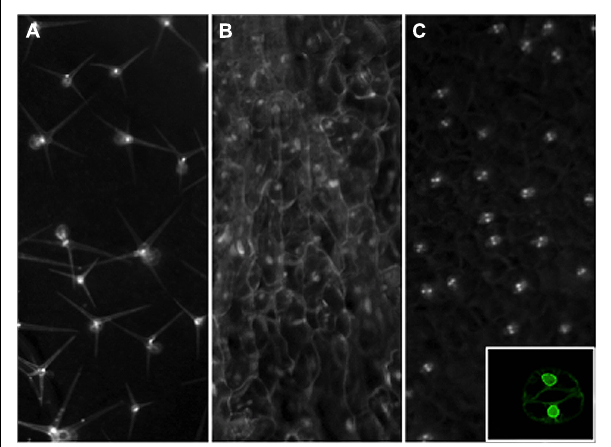
FIGURE 2 | Nuclear envelope tagging of specific leaf cell types in Arabidopsis . Transgenic plants were created with Inserts that express an NTF marker gene driven by the GL2 (A) , CaMV35S (B) , or AtMYB60 (C) promoters for trichome, constitutive, or guard cell-specific expression.The NTF marker is a nuclear envelope-anchored GFP fused to a biotinylation epitope from bacteria. For the GL2 promoter driven construct, a separate vector is used to produce the bacterial BirA gene in trans to catalyze the biotinylation of the NTF in order to facilitate rapid nuclei purification (Deal and Henikoff, 2010).To create a more facile labeling system, we have generated a new INTACT vector that contains both the NTF expression cassette as well as the BirA gene for plant expression.The CaMV 35S promoter and a guard cell-specific promoter from the AtMYB60 gene are used to create the constructs shown in panels (B) and (C) , respectively. Mature rosette leaves from stable transgenic lines are examined by a stereo epifluorescence microscope fitted with a GFP filter set for images shown. Inset on panel (C) shows a confocal image of a tagged guard cell from a single focal plane to Illustrate the nuclear envelope localization of the expressed NTF protein from the new vector driven by the AtMYB60